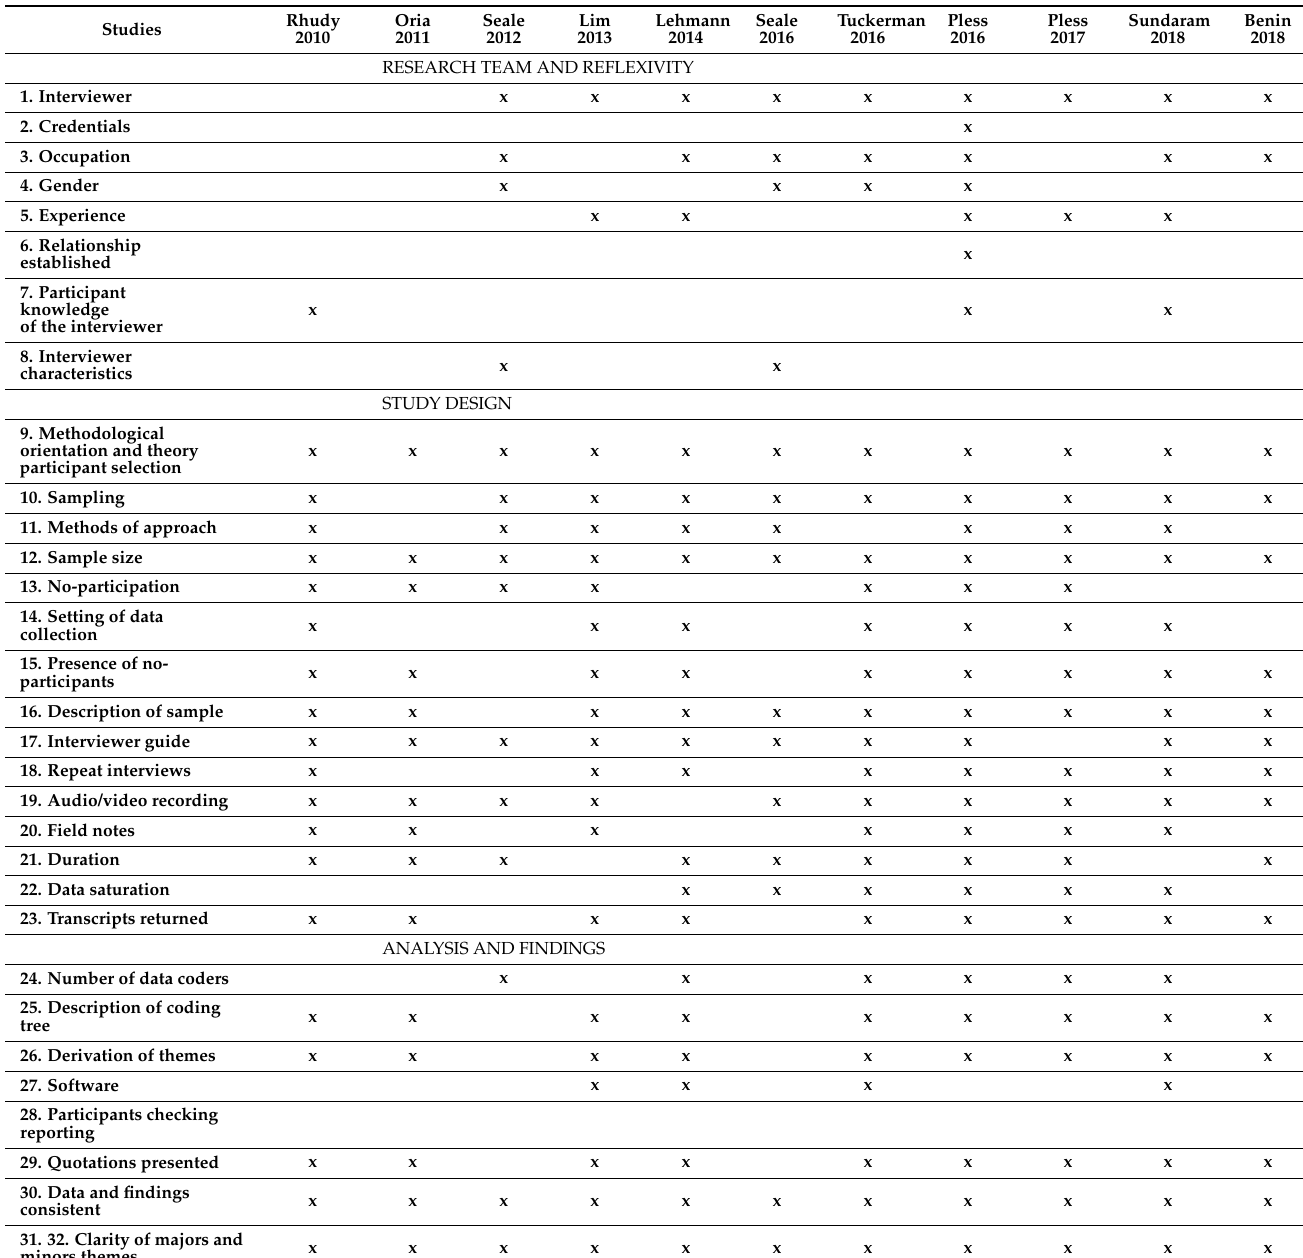
Table 2. Quality assessment of selected studies with the COREQ